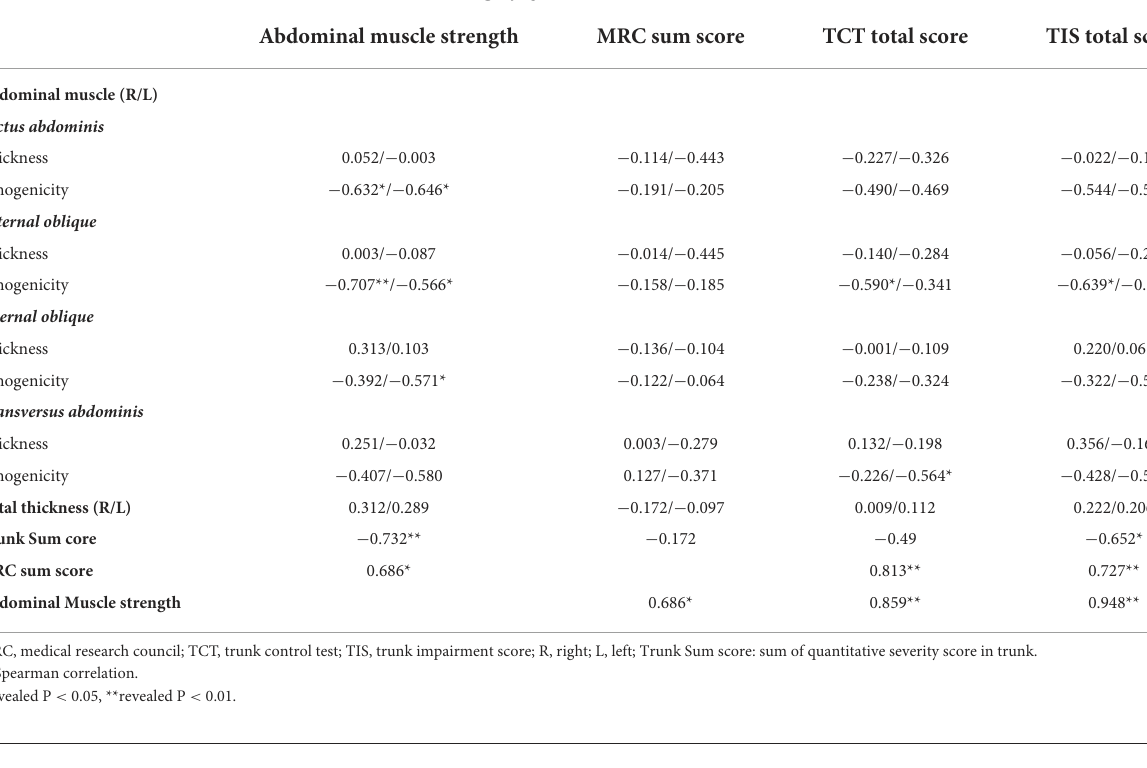
TABLE 3 Correlation between function tests and muscle sonography of trunk muscles ‡ .